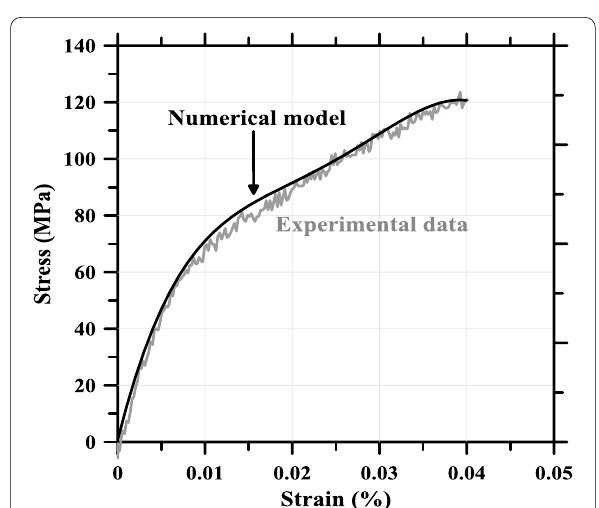
Fig. 13 PET stress – strain relationship (up to 4%